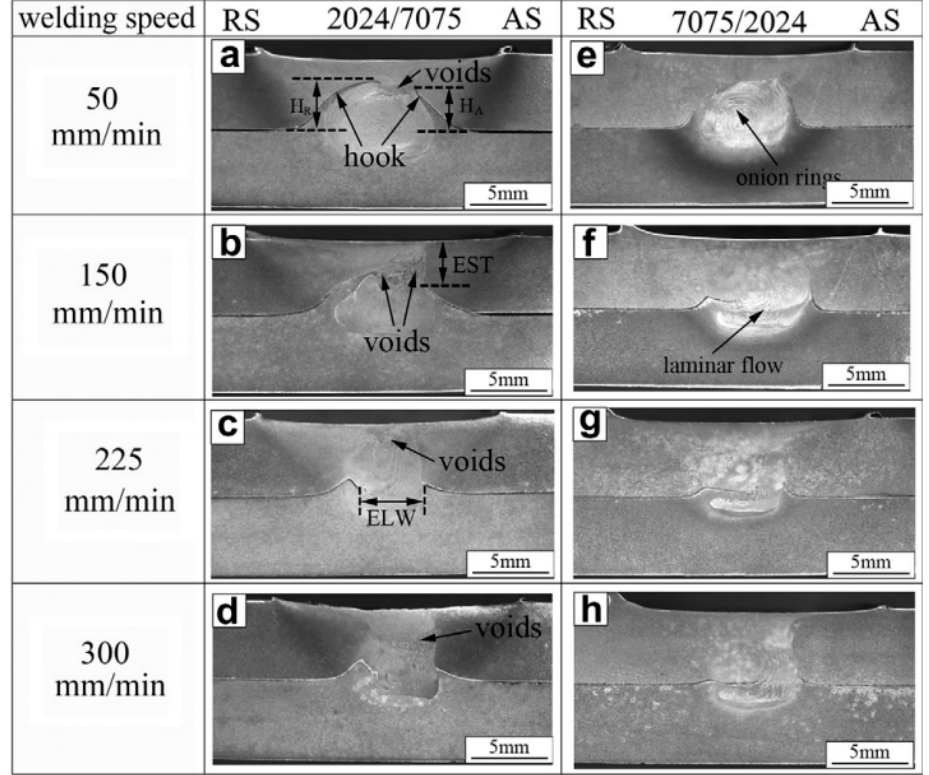
Figure 6. Cross sections of lap joints produced at various welding speeds: AA2024 as top plate (a) 50, (b) 150, (c) 225, (d) 300 mm/min; AA7075 as top plate (e) 50, (f) 150, (g) 225, (h) 300 mm/min, reproduced from [53], with permission from Elsevier, 2014.